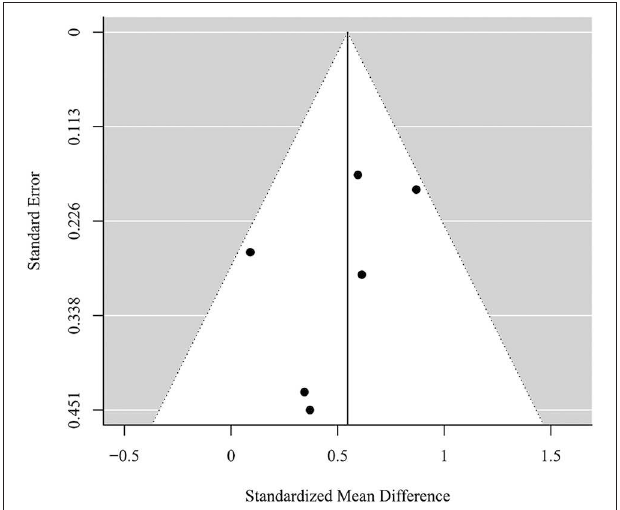
FIGURE 4 | Funnel plot for the meta-analysis of the effect of self-management smartphone-based apps on PTSD symptoms.